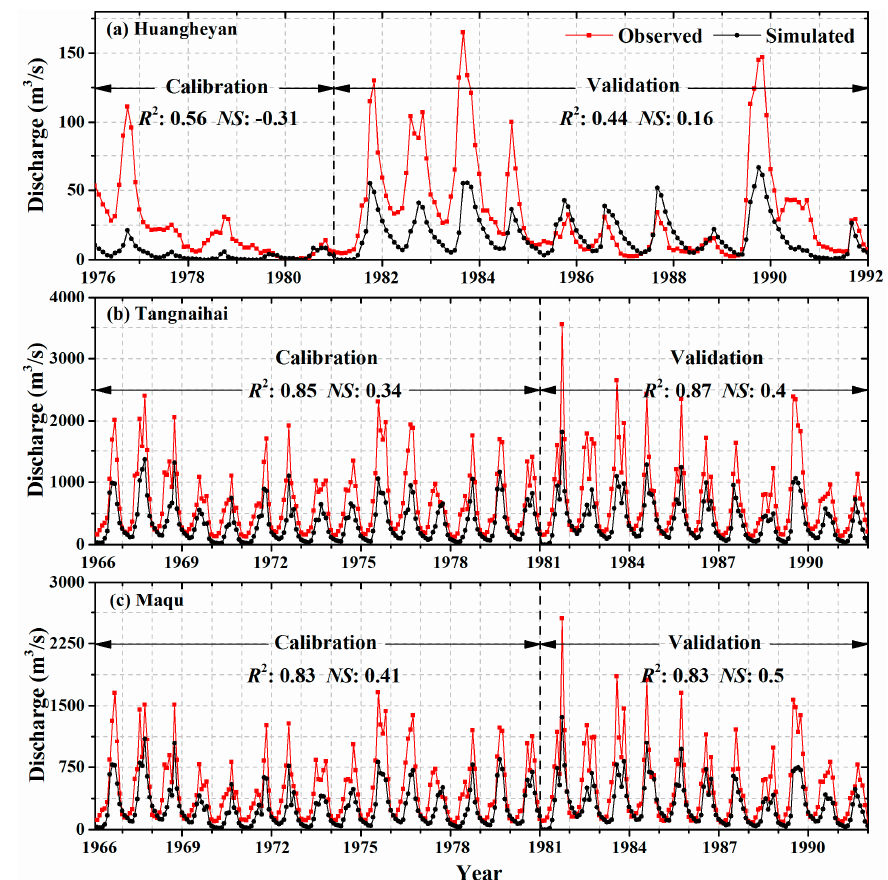
Figure 3. Monthly runoff simulations compared to observations for the calibration period (1976–1980 for Huangheyan; 1966–1980 for Tangnaihai and Maqu) and the validation period (1981–1991) without the inclusion of elevation bands.